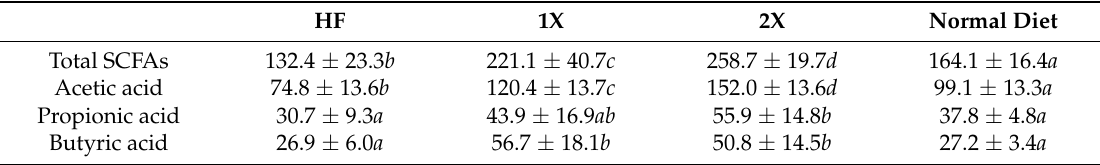
Table 5. Changes in the fecal short chain fatty acids ( µ mol/g 1 ) among different diet